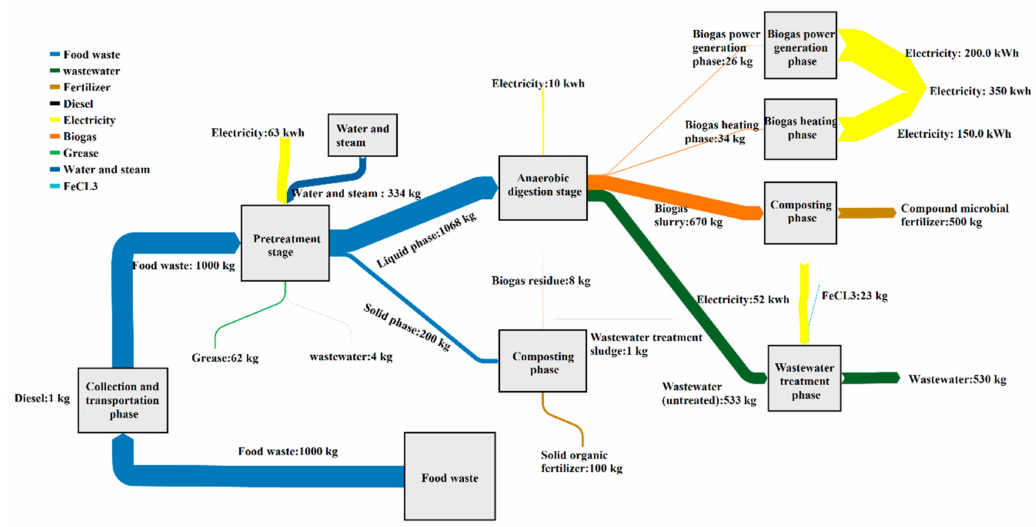
Figure 2. Life-cycle inventory of restaurant food waste in